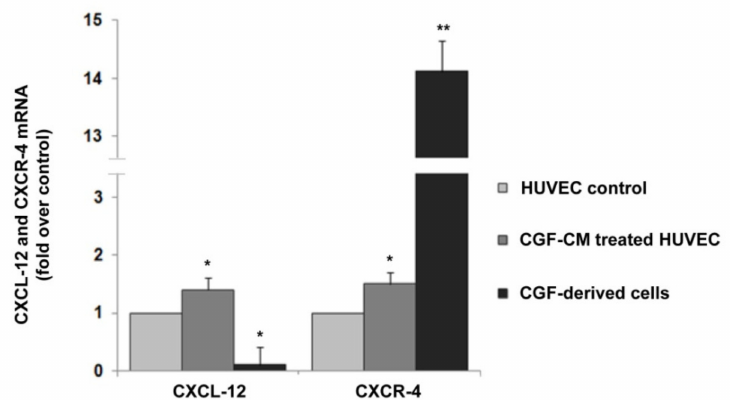
Figure 7. CXCL-12 and CXCR-4 expression in CGF-derived cells and CGF-CM-treated endothelial cells. mRNA was extracted from CGF-derived cells and CGF-CM (10%)-treated HUVECs for 4 h, and the expression levels of CXCL-12 and CXCR-4 were analyzed by qRT-PCR and expressed as fold over unstimulated HUVEC control (mean ± SD). Each experiment consisted of four replicates for each condition. * p < 0.05 and ** p < 0.01 vs. HUVEC